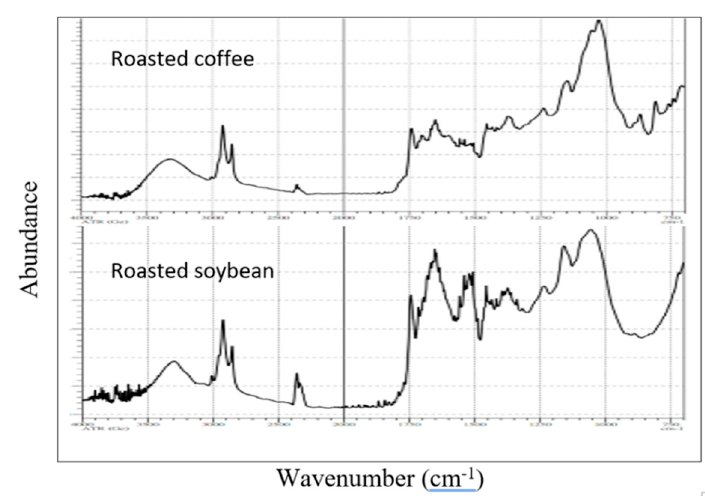
Figure 4. FTIR (ATR, Ge) spectra of roasted coffee beans and soybeans.